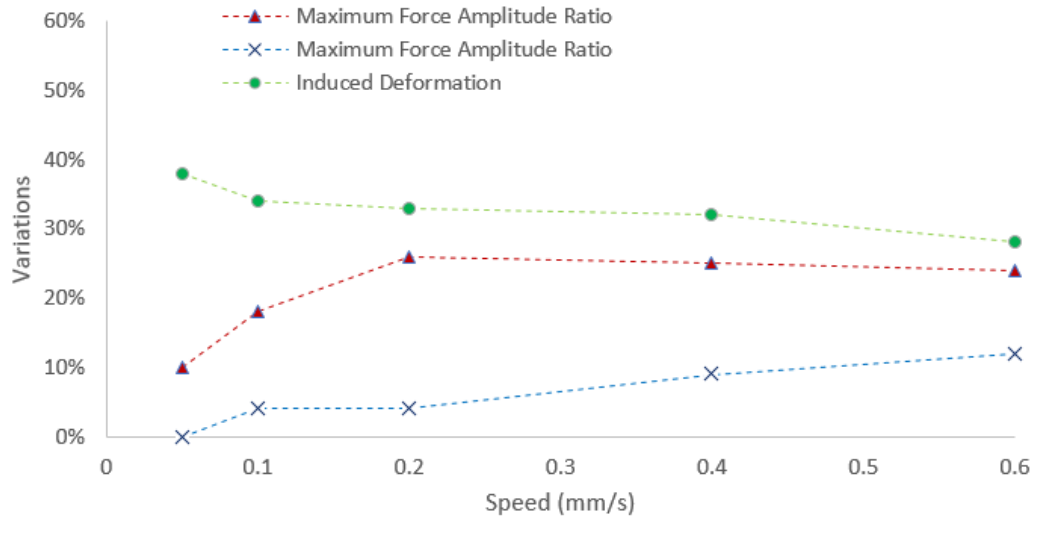
Figure 10. Influence of injection speed on oocyte deformation, injection force, and force